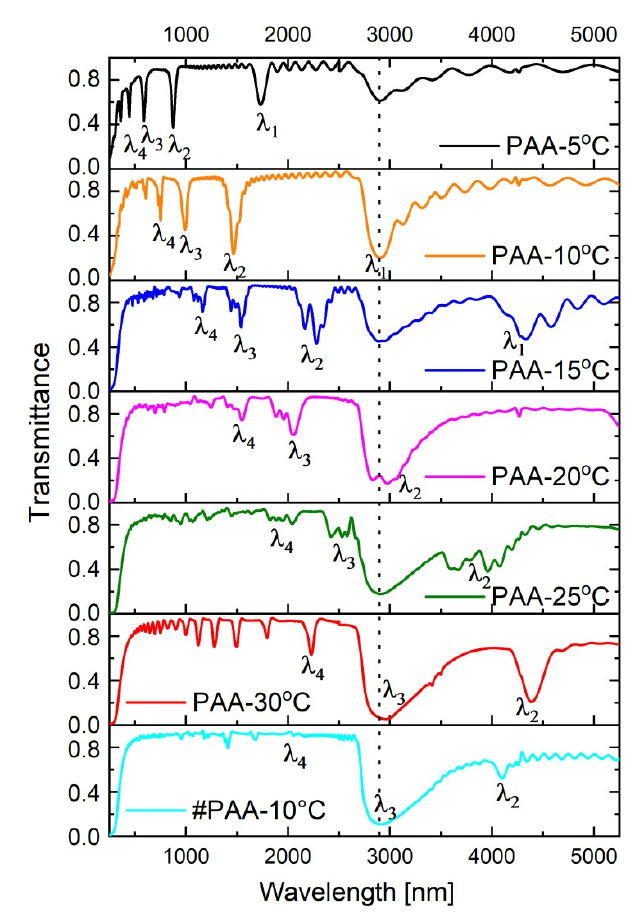
Figure 5. Transmittance spectra of PAA-based photonic structures anodized at temperature range 5–30 °C (the broad peak at around 3000 nm, present in all spectra and marked by vertical, black, dotted line, originate from OH group vibrations of adsorbed water [49]).